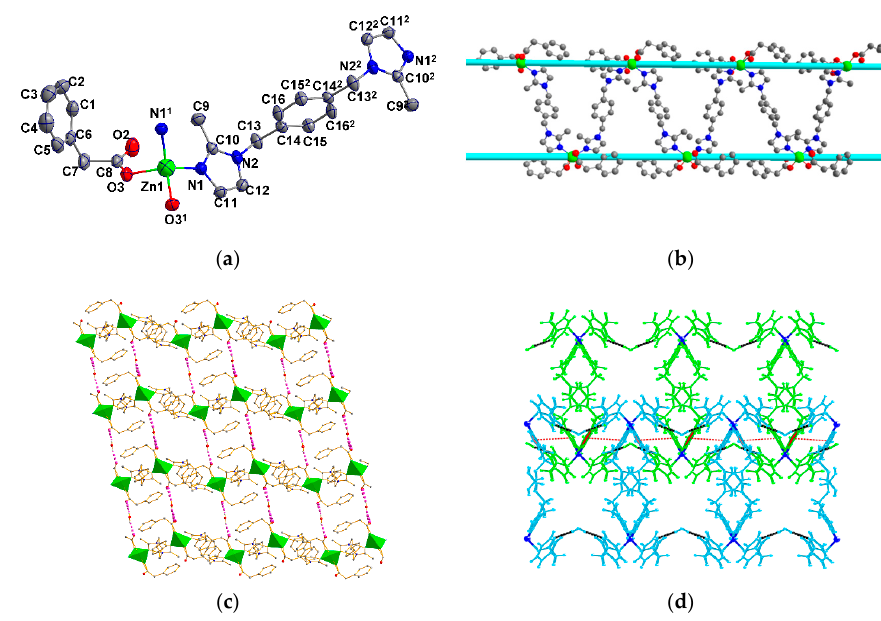
Figure 1. The structure of compound 1 : ( a ) coordination environment of the Zn(II) ion (symmetry transformations used to generate equivalent atoms codes: 1 1 − X, +Y, ½ − Z; 2 1 − X, 1 − Y, − Z), ( b ) 1D Z-type chain structure, ( c ) polyhedral representation of the 2D layer, ( d ) 3D framework formed by π ··· π interactions and hydrogen bonding (green, Zn; red O; blue, N; gray, C).